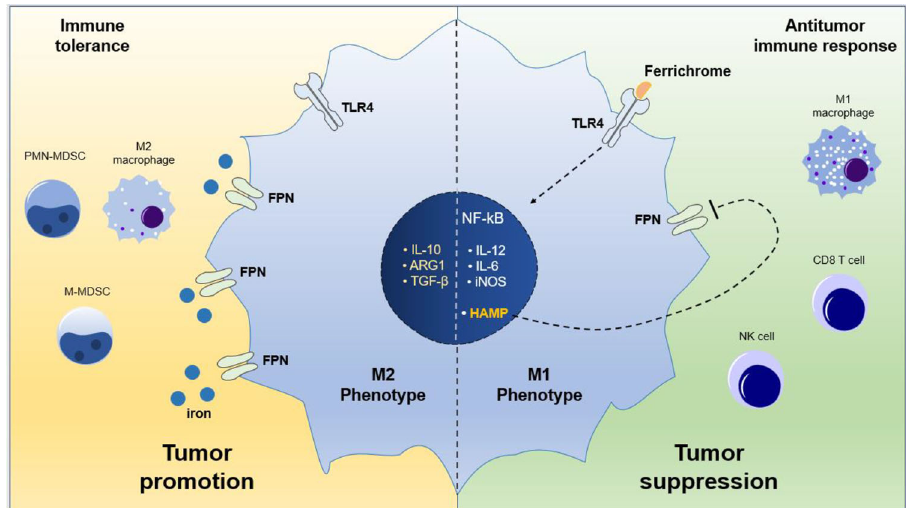
Fig. 8 Schematic representation illustrating summarized fi ndings. Ferrichrome polarizes macrophages to an M1-like phenotype via TLR4 activation which results in production of proin fl ammatory signals. TLR4 activation by ferrichrome modulates iron metabolism via downregulation of iron export protein Fpn via endogenous production of hepcidin. Activation of M1-like macrophages drives an antitumor immune response against pancreatic tumor cells via increase in fi ltration of CD8 + T